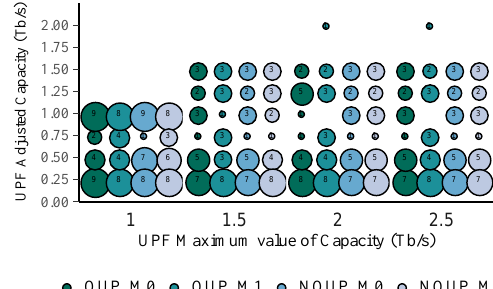
Figure 8. UPF adjusted capacities vs. maximum capacity for services with high requirements.